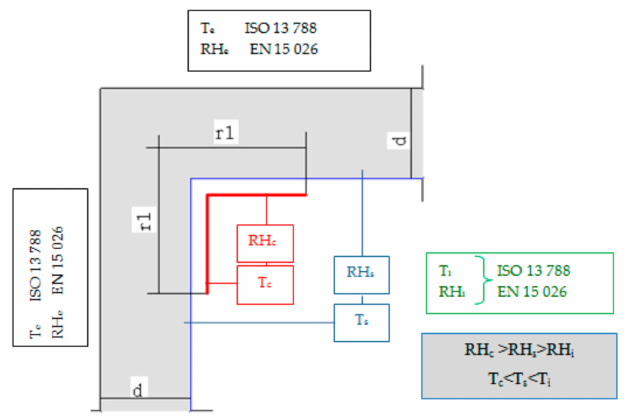
Figure 2. Assumptions (index i—Inside, s—Surface,